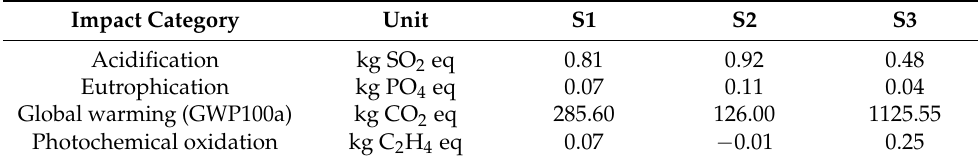
Table 3. Environmental impact with each MWh of electricity